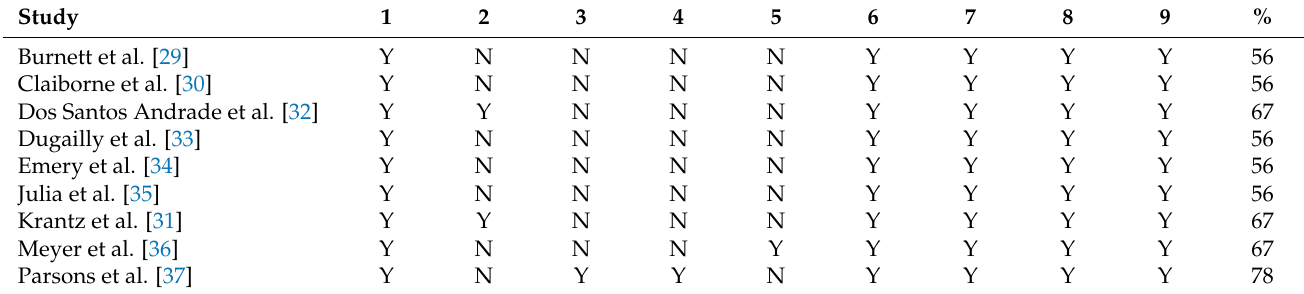
Table 5. Evaluation of the quality of studies with the critical evaluation tool (CAT).